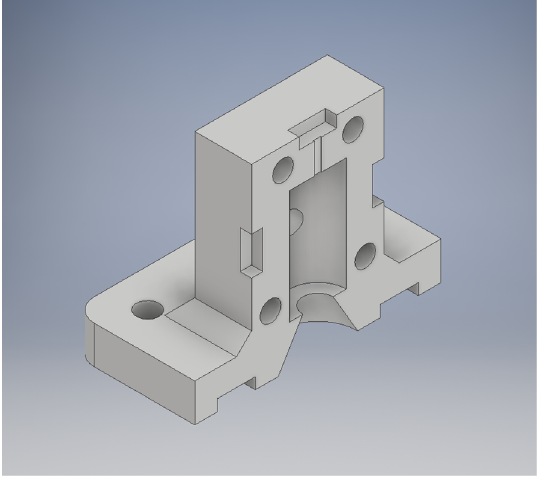
Figure 5. STL rendering of compression specimen mold.